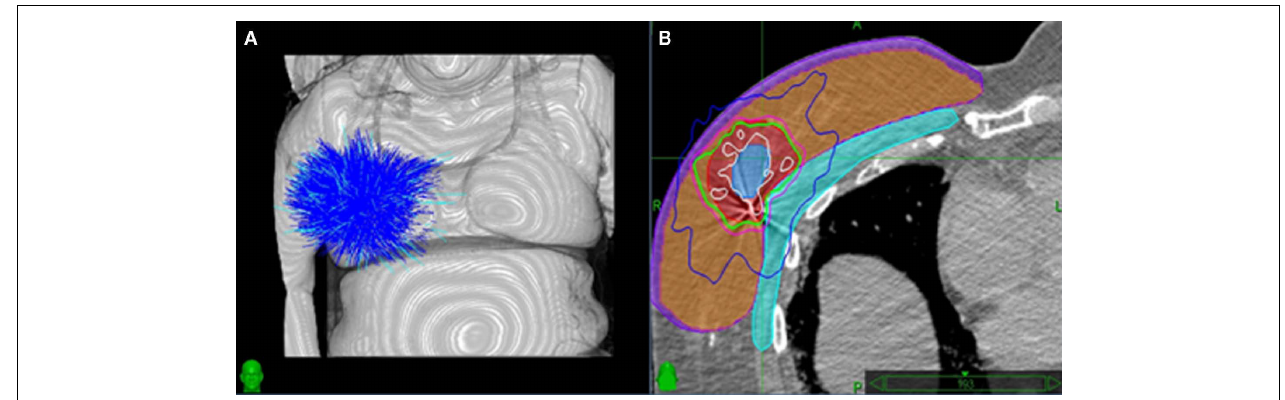
FIGURE 2 | CyberKnife treatment planning images for a patient in the 34-Gy dose group. (A) Illustration of beam trajectories and (B) axial treatment planning image illustrating the omission of high doses to the chest wall and skin. Shown in (B) are three isodose lines at the 70, 50, and 30%.The green contour represents the planning target volume.